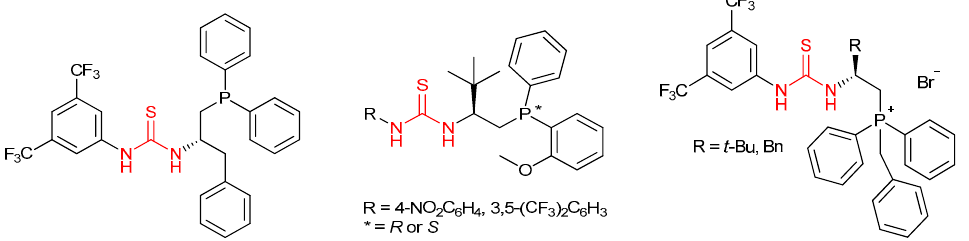
Figure 24. Examples of chiral thioureas bearing phosphine functionalities[305,307] and a phosphonium salt [308].